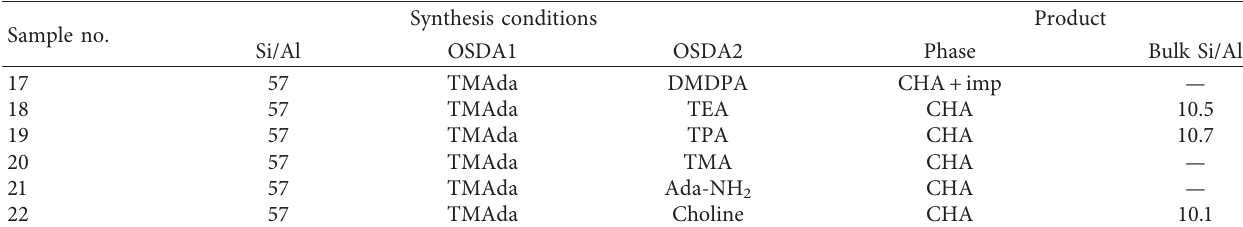
Table 3: Synthesis of CHA zeolites using a mixture of two organic templates. Sample